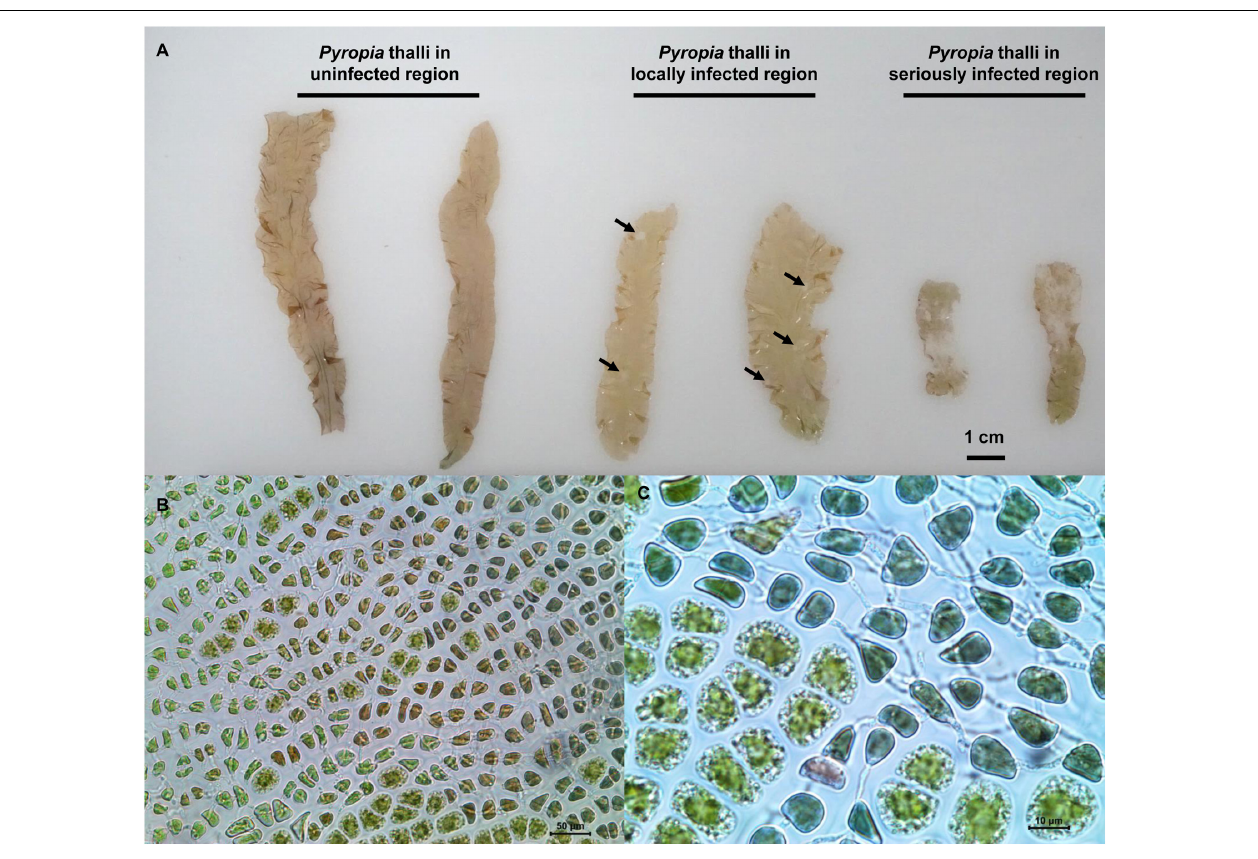
FIGURE 1 | Comparison of different health-status Pyropia yezoensis thalli collected from three regions in the cultivation farms (A) and enlarged images of the thalli infected with Pythium chondricola (B,C) . The red rot section in the thallus is indicated by the